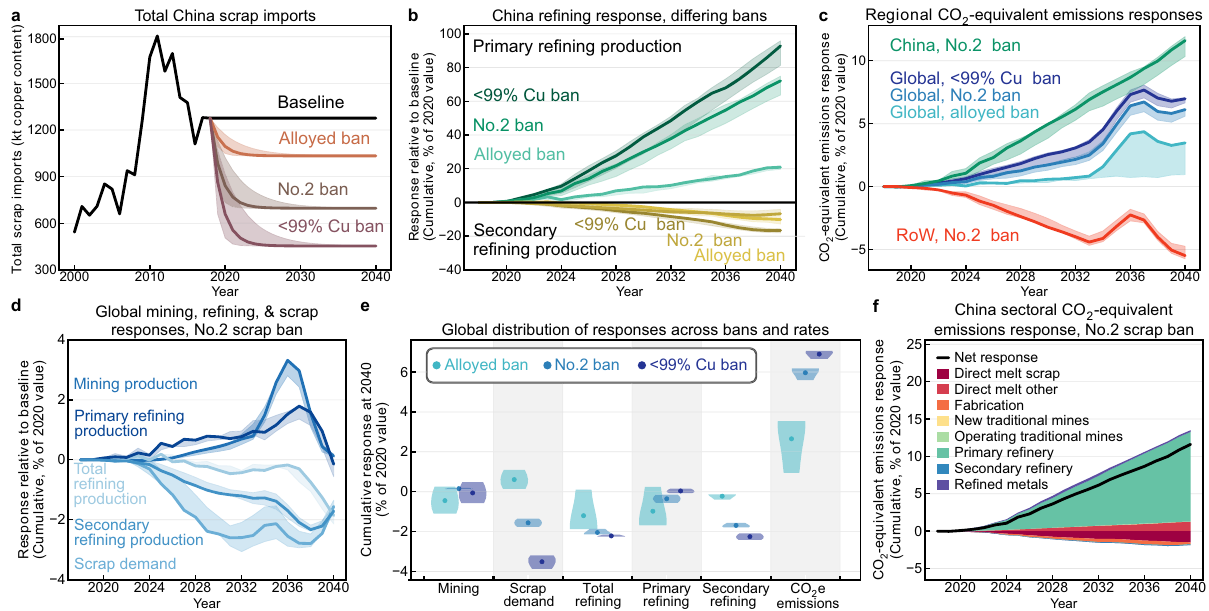
Fig. 3 System response for China ’ s solid waste import ban, No.2 ban with additional emphasis. In each sub fi gure, the shading surrounding solid lines corresponds to the variation in ban rate: 25, 50, or 75% reduction in China ’ s scrap imports year over year, where solid lines represent a 50% year-over- year ban of the listed scrap type. a Scrap imports for each scenario in copper content. b Cumulative primary and secondary re fi ning responses in China relative to baseline for each scenario using total re fi ning production as reference. c Cumulative global CO 2 e emission responses for each scenario, with China and RoW responses for the No.2 scrap ban only. Global values are used as divisors for regional parameters for ease of comparison. d Cumulative global mining, re fi ning, and scrap demand responses for the No.2 scrap ban over the simulation period. Labels correspond with relative positions of their values at 2040. e The distributions of global mining, scrap demand, total re fi ning, primary re fi ning, secondary re fi ning, and CO 2 e emissions responses for each ban, evaluated cumulatively at 2040 relative to baseline. Points represent the mean of the three ban rates, while the shaded regions represent the distributions of ban rate results. f Cumulative sectoral CO 2 e emission response for China, where all increasing impacts were plotted above the x -axis, all decreasing impacts were plotted below the x -axis, and the black line represents the net response within China as a result of these sectoral changes. Underlying data used to create this fi gure may be found in a data repository at https://doi.org/10.6084/m9. fi